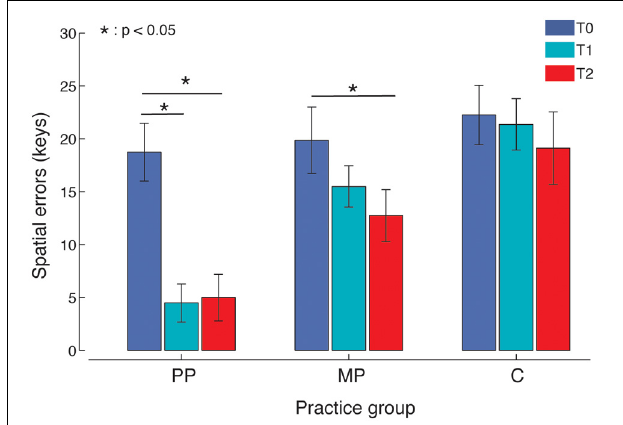
FIGURE 3 | Spatial errors. PP, Physical practice; MP, Mental practice; C, Control group (no practice). Both MP and PP, but not C, significantly reduced the number of spatial errors. PP was effective after the first practice block and resulted in significantly better performance.